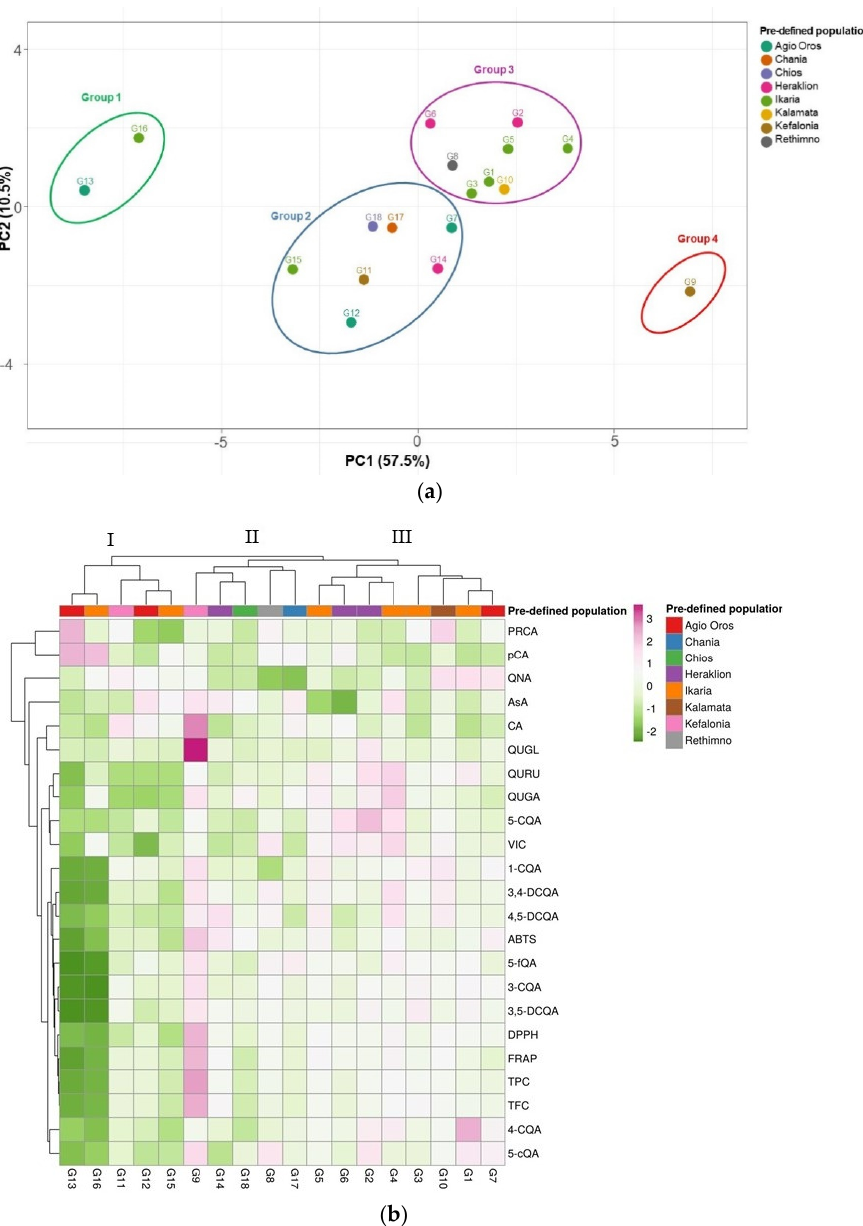
Figure 4. Two-D PCA plot of the first two components of 18 native Greek rock samphire genotypes (see Table 1) based on 23 determined traits related to bioactive compounds and antioxidant activity ( a ), and a heat map showing fold changes of the same traits of the 18 rock samphire genotypes ( b ). Columns are centered; unit variance scaling is applied to columns. Columns are clustered using Euclidean distance and Ward linkage (23 rows, 18 columns).